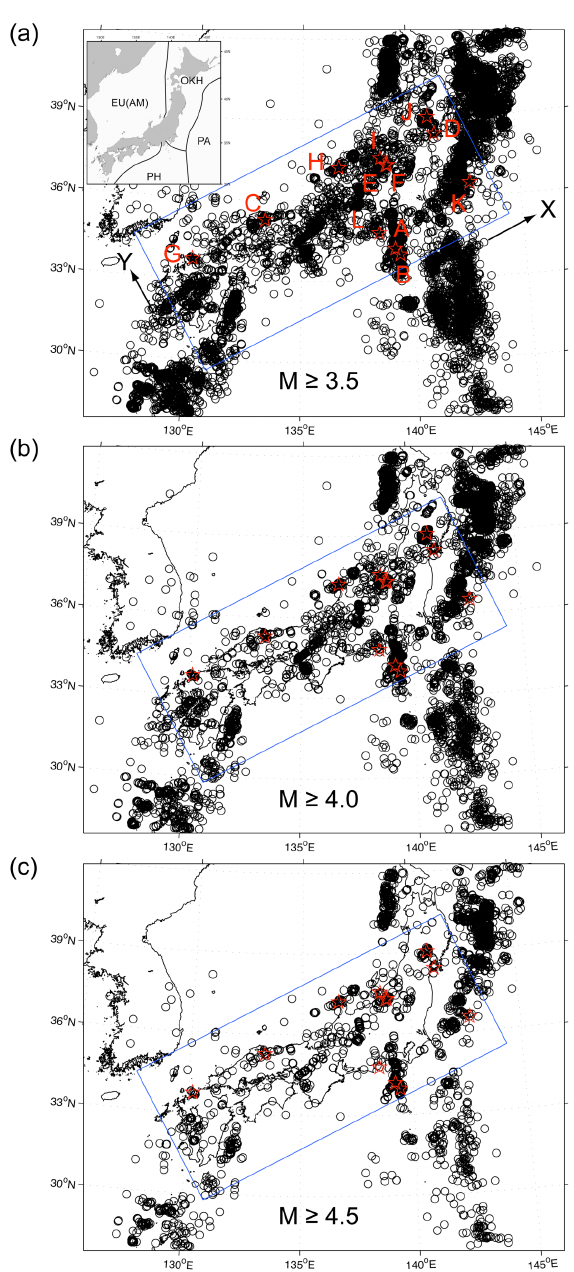
Fig. 1. Maps showing epicenters within rectangular regions used for PI analysis for threshold magnitudes of (a) 3.5, (b) 4.0, and (c) 4.5. The red stars with labels (A)–(L), which correspond to earthquake indices in Table 1, indicate the locations of large earthquakes with magnitudes larger than M = 6 . 4. The black circles denote locations of earthquakes with magnitudes larger than a threshold magnitude as shown in respective panels. The X and Y axes of the rectangular region in each panel correspond to the east-northeastward and its perpendicular (north-northwestward) directions, respectively. The inset of (a) shows a map view of the tectonic setting around the Japanese islands; PA: Pacific Plate, PH: Philippine Sea plate, EU (AM): Eurasian Plate (Amurian Plate), OKH: Okhotsk